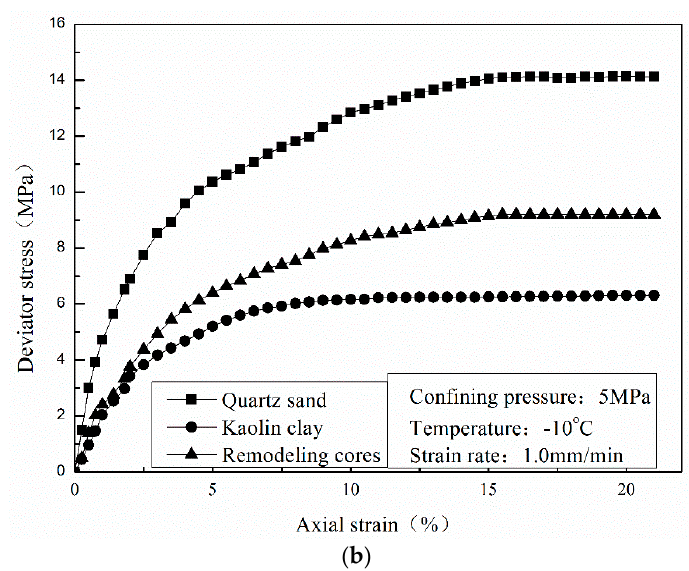
Figure 12. Stress-strain curves of the CH 4 and CO 2 hydrate-bearing sediments in different sediment matrices. ( a ) CH 4 hydrate-bearing sediments; ( b ) CO 2 hydrate-bearing sediments.